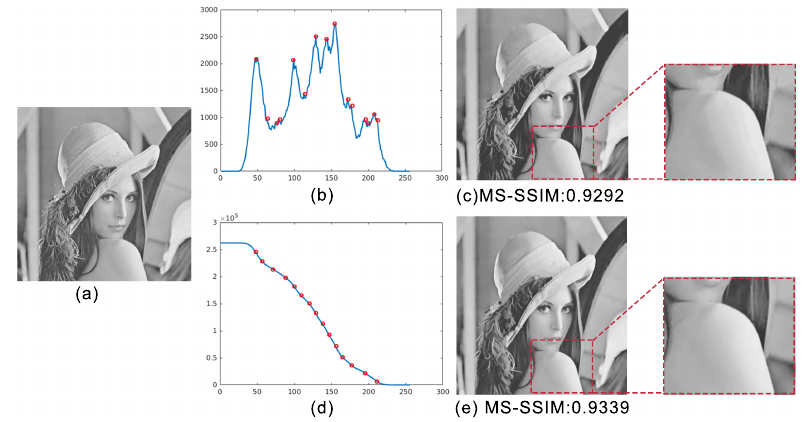
Figure 2. Layer selection methods. ( a ) Original image. ( b ) Histogram of ( a ), with local maxima marked in red. ( c ) Reconstruction of ( a ) using 15 most relevant layers given by ( b ). ( d ) Cumulative histogram of ( a ), with selected layers marked red. ( e ) Reconstruction of ( a ) using the 15 most relevant layers given by ( d ).